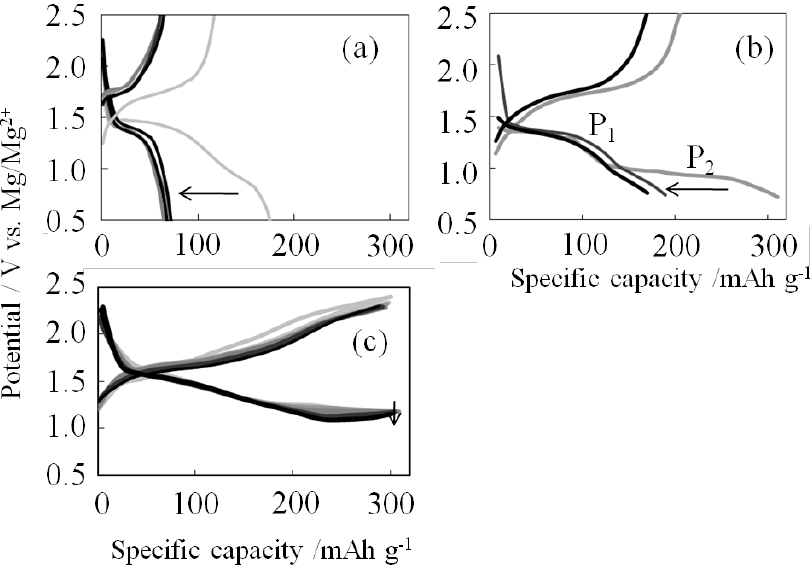
O ; ( b ) Mixture of S and V 2 5